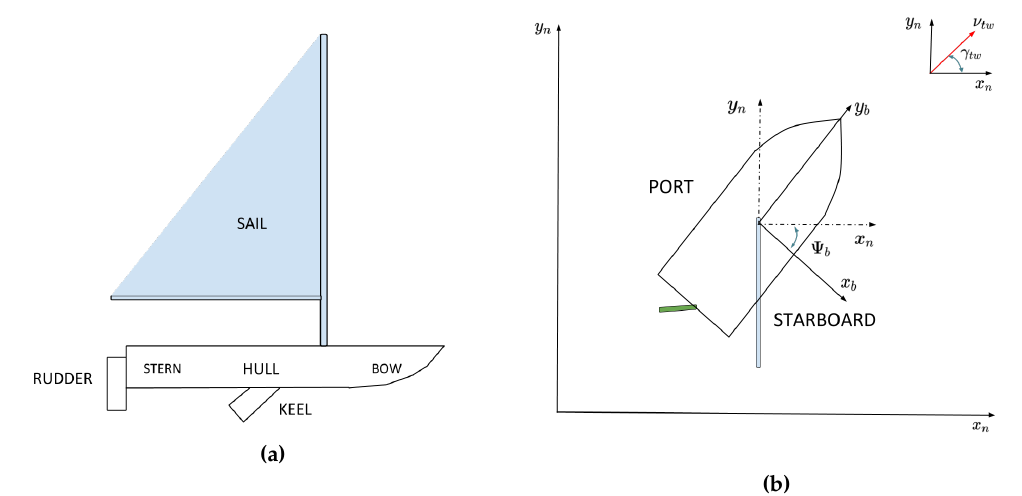
Figure 1. Main parts of a sailboat on ( a ). Frame of reference used in this paper on ( b ).